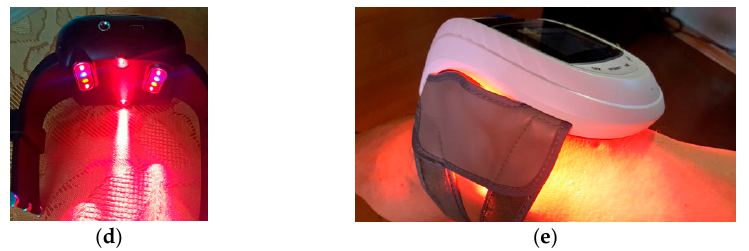
Figure 13. International ISLA (International Society for Medical Laser Applications) Congress, Beverungen, Germany, June 9, 2017 ( a – e ). ( a ) From left to right: Dr. Michael H. Weber (ISLA President), Dr. Michael Weber, Professor Gerhard Litscher (ISLA President), Dr. Volkmar Kreisel (ISLA Vice-President), Dr. Michael Grandjean (ISLA Vice President). Presidents of ISLA (International Society for Medical Laser Applications) and of the Congress: Professor G. Litscher (left) and Dr. M. H. Weber ( b ). Laser stimulation equipment for the wrist ( d ) and the knee ( e ).